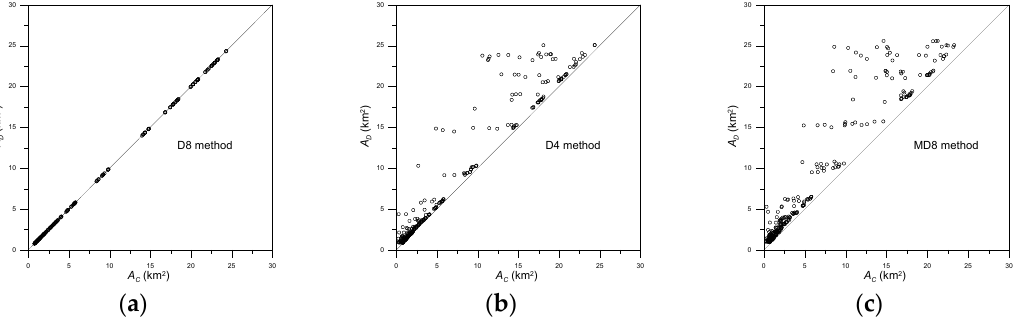
Figure 5. Variances between the flow dispersion area and the flow concentration area at the 300 locations using three selected flow-direction methods: ( a ) D8 method; ( b ) MD4 method; ( c ) MD8 method.